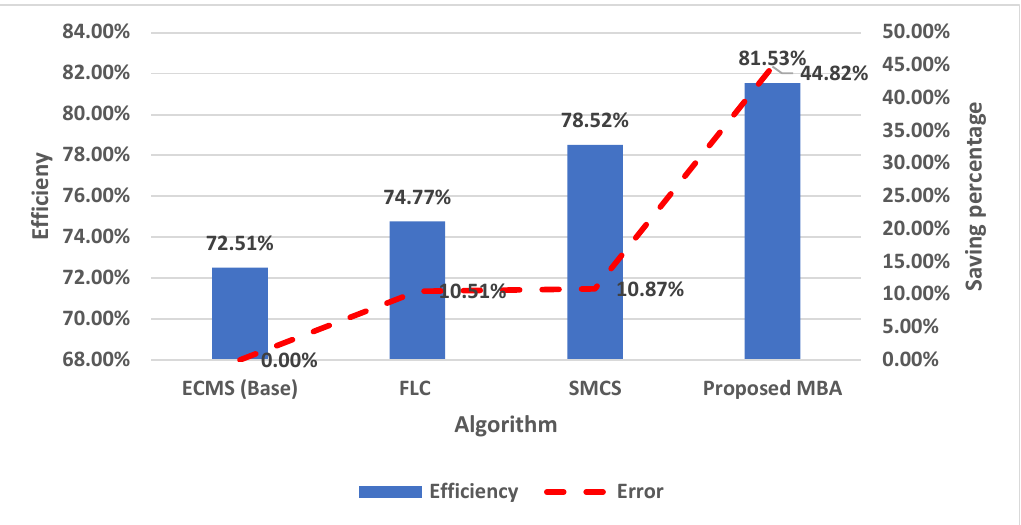
Figure 9. Overall efficiency and saving percentage of hydrogen consumption.